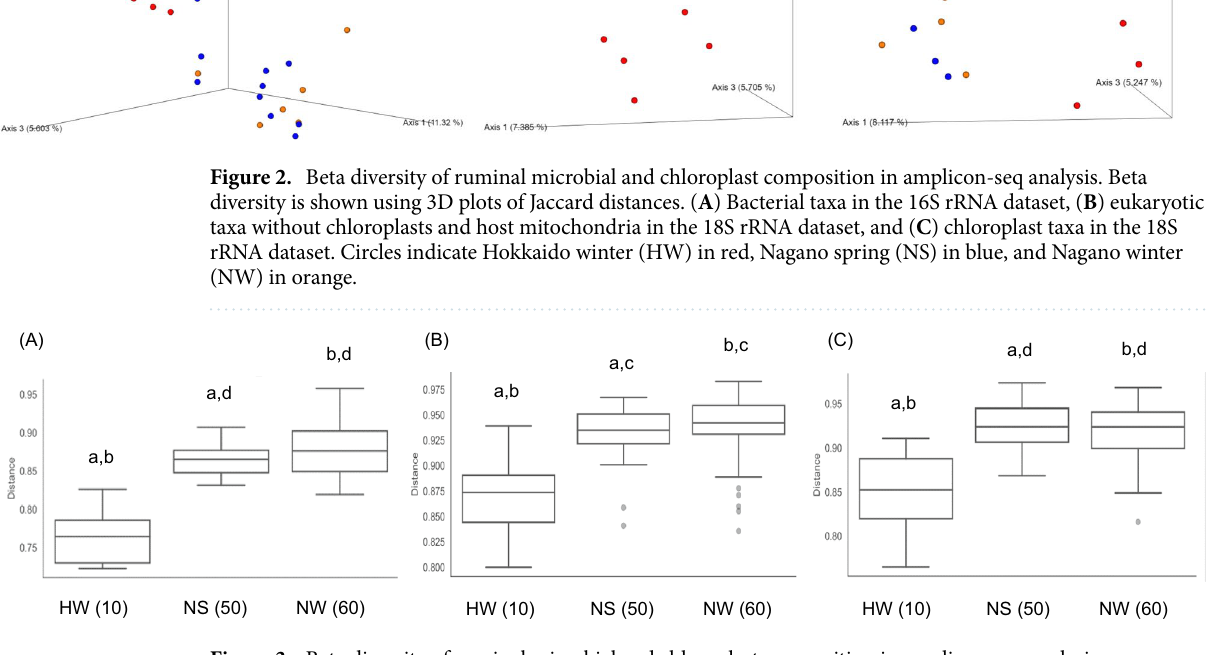
Figure 3. Beta diversity of ruminal microbial and chloroplast composition in amplicon-seq analysis. Comparisons among groups based on Jaccard distance metrics. ( A ) Bacterial taxa in the 16S rRNA dataset, ( B ) eukaryotic taxa without chloroplasts and host mitochondria in the 18S rRNA dataset, and ( C ) plant taxa in the 18S rRNA dataset. The distances from HW are shown. Differences in structure among groups were detected by PERMANOVA/ANOSIM. The same letters (a, b, c, and d) show statistically significant differences between groups (a, b, and c, p < 0.01; d, p < 0.05). (), number of distances calculated between samples within each